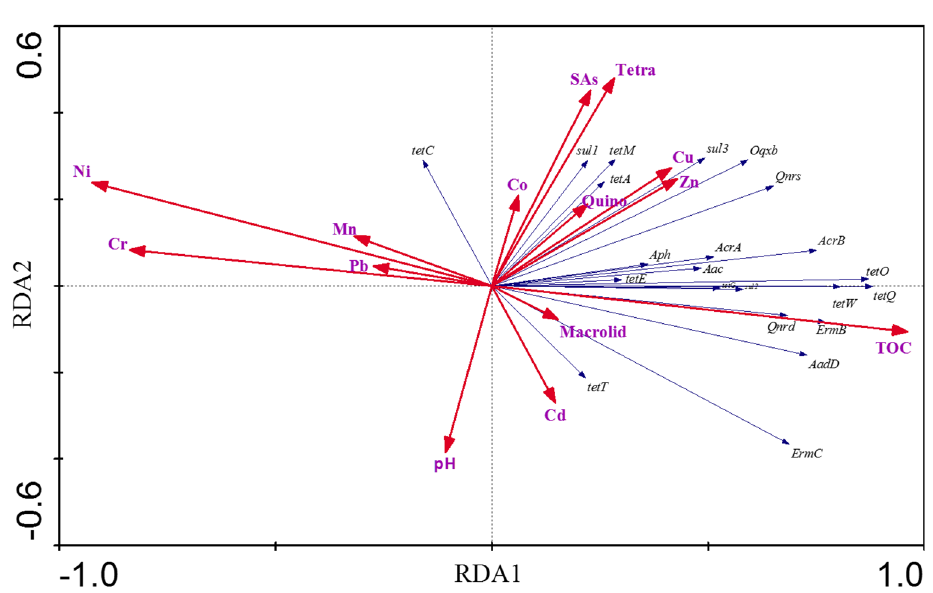
Fig 6. RDA results of absolute concentrations of 22 ARGs and environmental variables. (The angles between the arrows indicate the sign of the correlation between the ARGs and the associated environmental